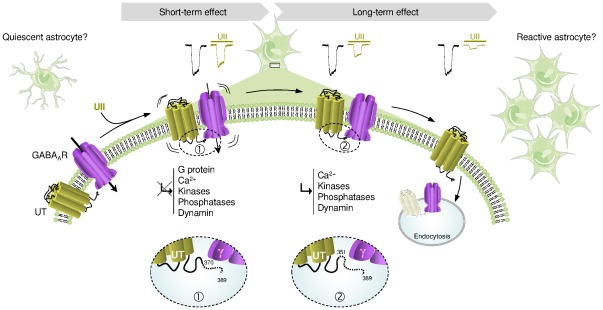
Schematic model depicting the mechanism of UT-mediated GABAAR down-regulation.UII efficiently activates the G protein-coupled receptor UT, leading to a fast short-term decrease of the chloride current not sustained by G proteins, calcium, phosphorylation and endocytosis processes. This rapid effect involves the distal 19 C-terminal amino acids of UT and the presence of γ subunits within of the GABAAR complex (1). During the washout period, a long-term inhibition develops via a dynamin-, calcium- and phosphorylation-dependent endocytic mechanisms, requiring at least in part the 351–370 sequence of UT and GABAAR γ subunits (2). It is hypothesized that the directional cross-talk between UT and GABAAR, and the extinction of the latter at the plasma membrane, may relay transition from quiescent to proliferant astrocytes.